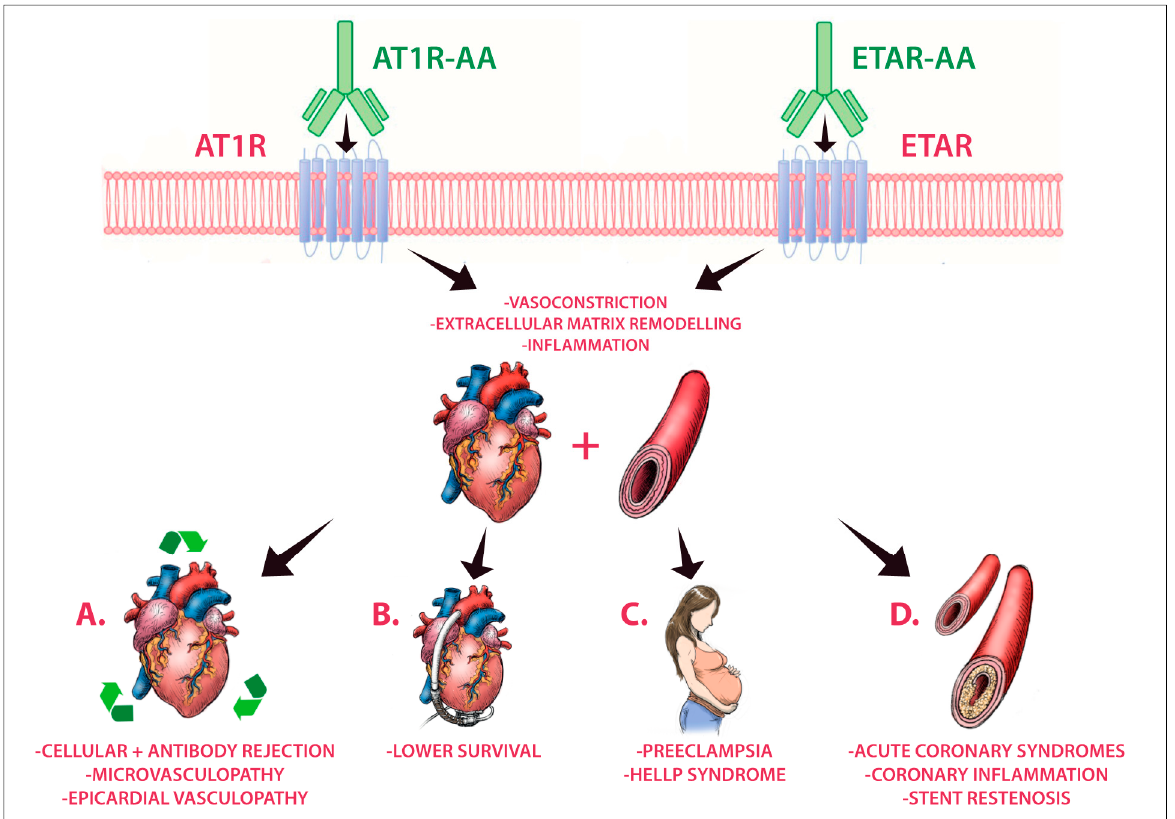
Figure 1. Angiotensin II receptor type 1 (AT1R) and endothelin-1 receptor type A (ETAR) are G-protein coupled-receptors (GPCRs) that are physiologically activated by angiotensin II and endothelin 1, respectively. AT1R and ETAR can also be activated by functional circulating autoantibodies (AT1R-AAs and ETAR-AAs, respectively) that promote vasoconstrictor, profibrotic, and proinflammatory responses. In heart transplant recipients (panel A ), the presence of AT1R-AAs and ETAR-AAs is associated with graft microvasculopathy, epicardial coronary artery vasculopathy and with cellular- and antibody-mediated rejection. In patients with mechanical circulatory support (panel B ), a higher prevalence of AT1R-AAs is reported, and it is associated to lower survival. AT1R-AAs are also present in almost all preeclamptic patients, while ETAR-AAs only appear in more severe stages of disease (panel C ). As regards patients with acute coronary syndromes (panel D ), higher levels of AT1R-AAs are reported, and their presence is associated with coronary inflammation and stent restenosis.